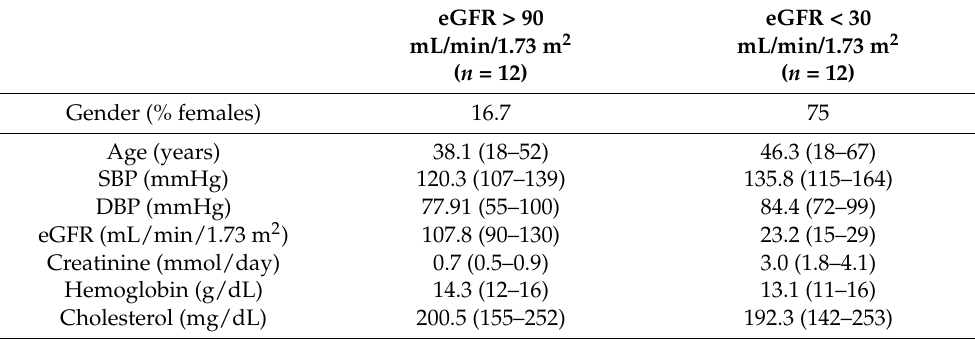
Table 5. Clinical information of the study population. The mean values (ranges) are